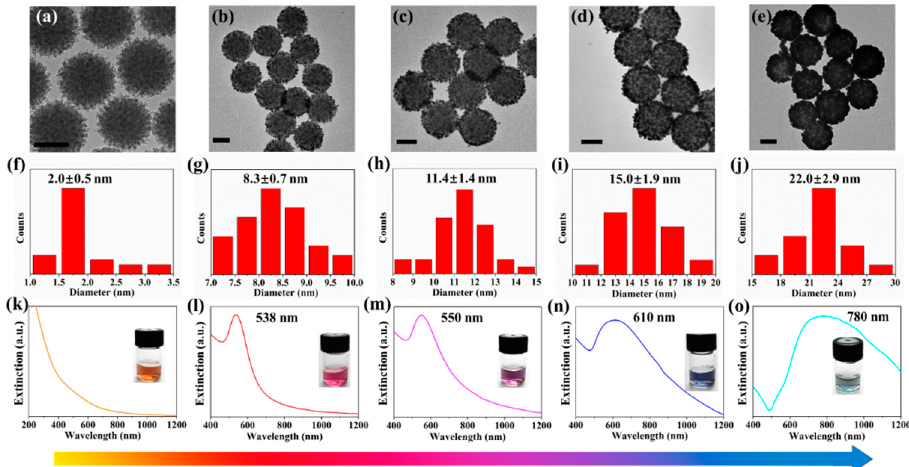
Figure 2. A TEM image of ( a ) AuNCs, and AuNRbs synthesized using a HAuCl 4 solution with a concentration of ( b ) 0.025 mM, ( c ) 0.0375 mM, ( d ) 0.075 mM and ( e ) 0.225 mM, respectively. The scale bar is 100 nm. ( f – j ) The size distribution of assembled gold nanoseeds and gold nanoparticles corresponding to ( a – e ), respectively. ( k – o ) The extinction spectrum with an inset showing the photo of colloid solution corresponding to ( a – e ), respectively.